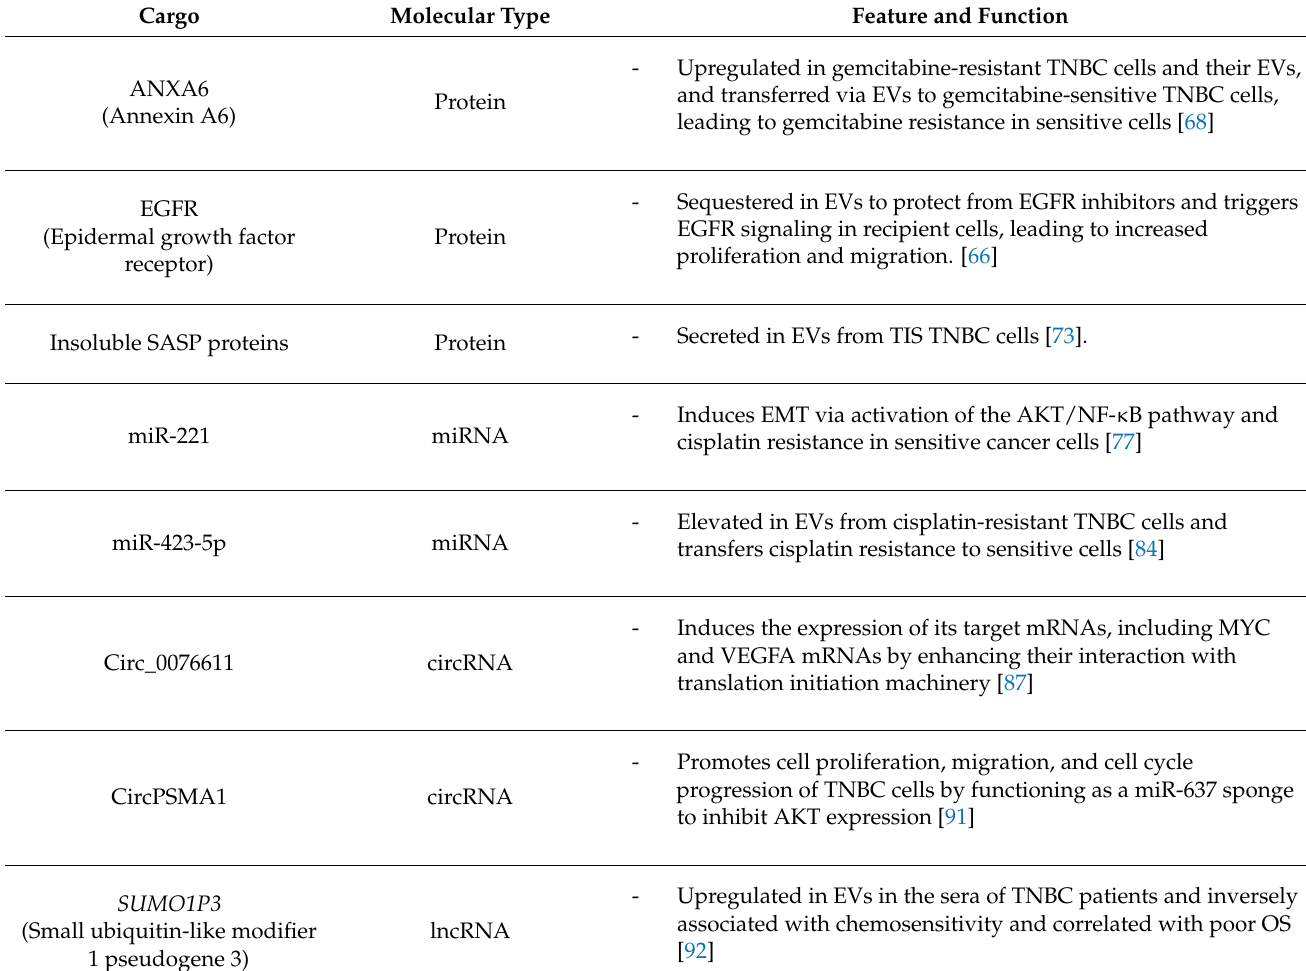
Table 1. TNBC-EV cargo components that confer resistance to anticancer